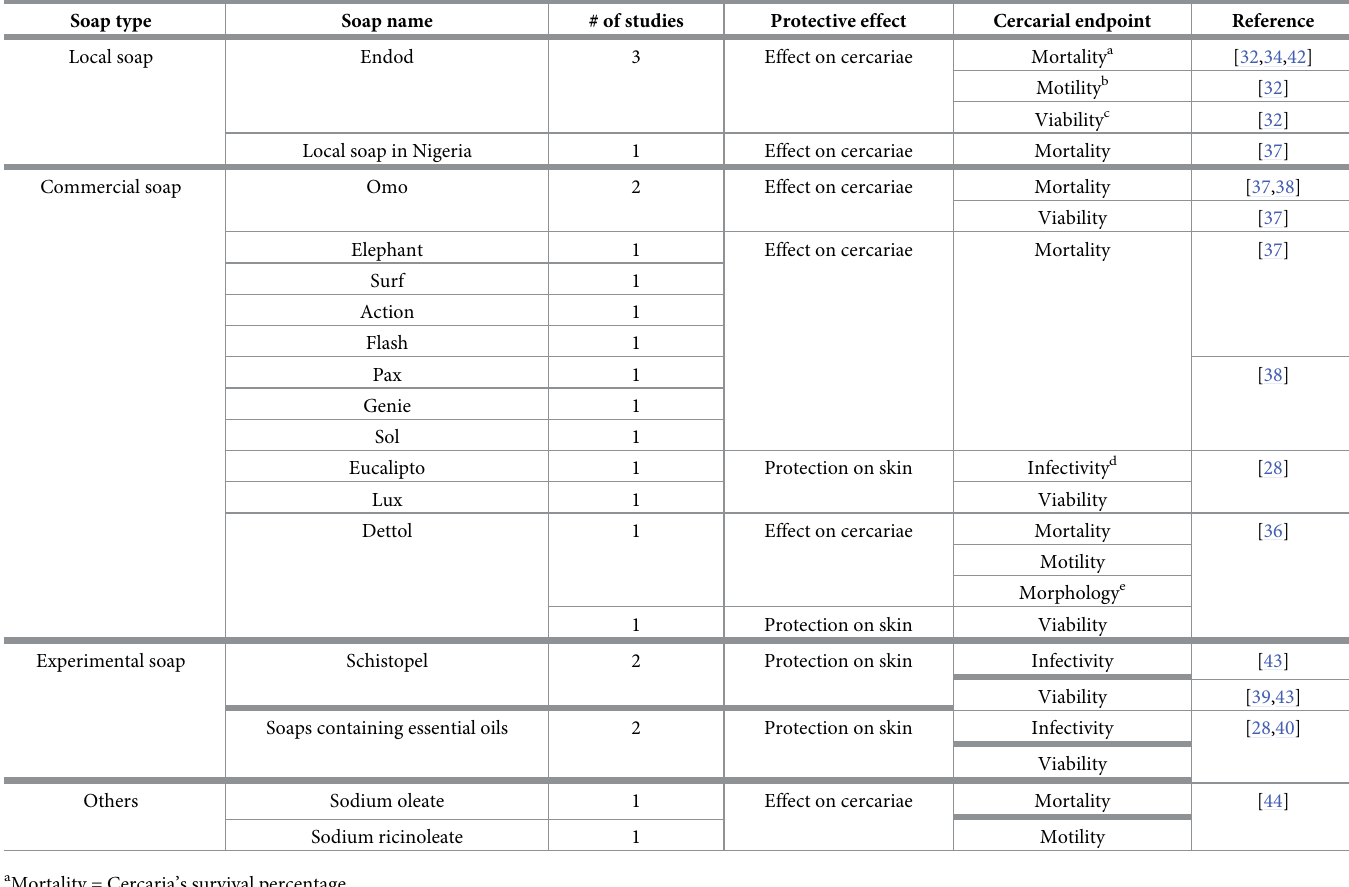
Table 1. Summary of the soaps considered in the included